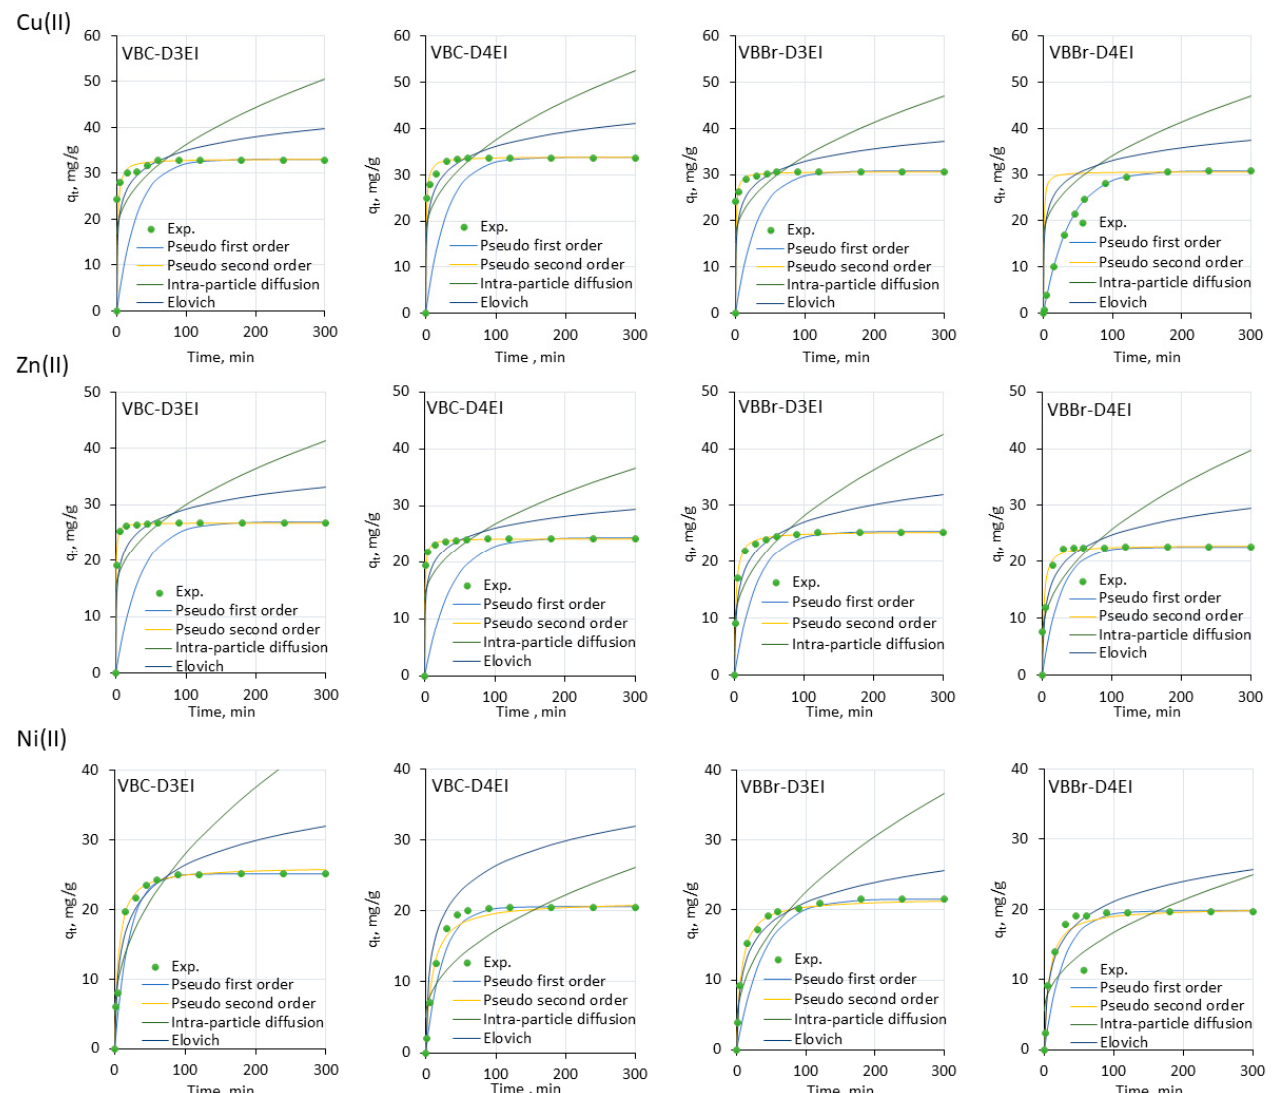
Figure 8. Experimental data of adsorption kinetics and non-linear fitting of kinetic models for adsorption of Cu(II), Ni(II), and Zn(II) onto resin surfaces (metal ion concentration, 50 mg/L; sorbent dosage, 0.1 g; V, 100 mL, pH 5).